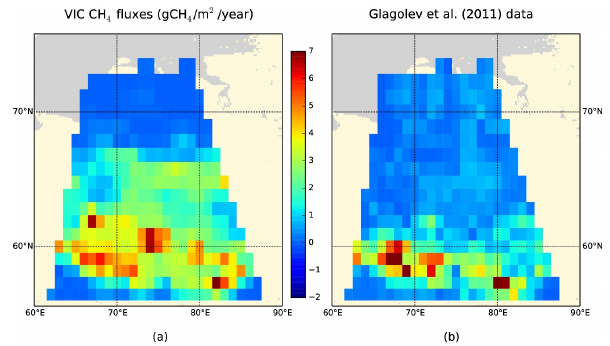
Figure 4. Comparison of simulated CH 4 emission rate and field- campaign-based data over WSL. (a) VIC simulated fluxes; (b) field- campaign-based flux data from Glagolev et al. (2011).